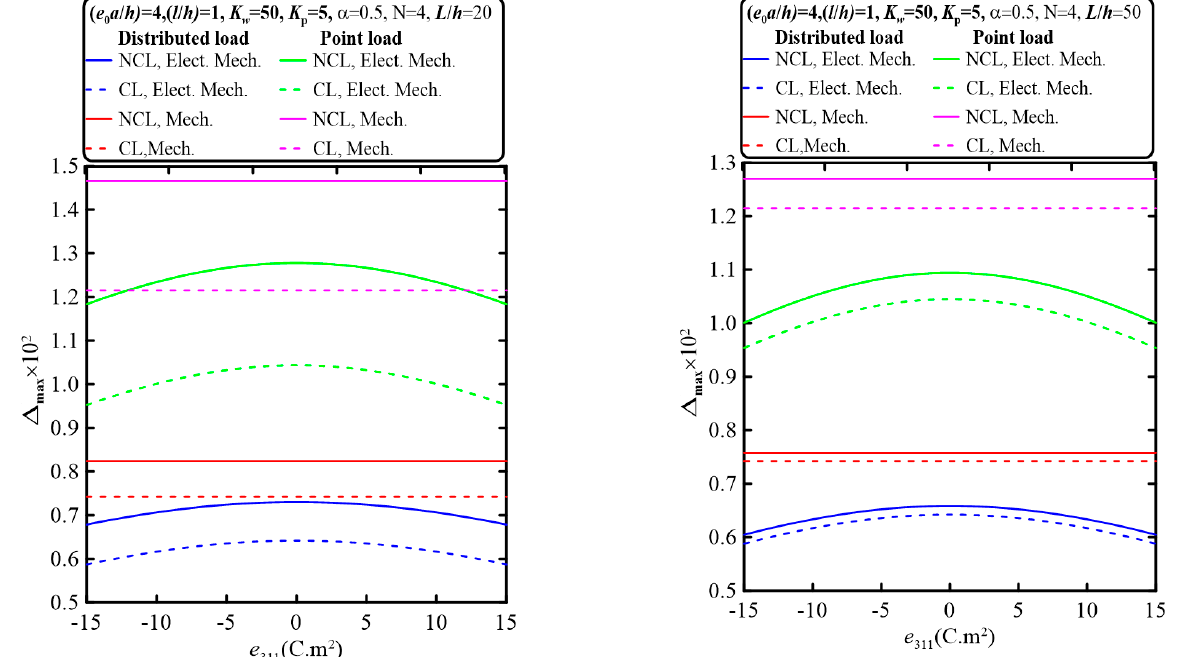
Figure 10. Variation in the maximum normalized transverse deflection Δ max with the piezoelectric coefficient e 311 for nonclassical and classical electromechanical and mechanical behaviors under uniformly distributed and point loads at different values of the nonclassical and elastic foundation parameters at α = 0.5 and beam aspect ratio L / h = 20, 50, h p = 1 nm, h c = 3 nm, h = 15 nm, N = 4, μ 3111 = 5 ×